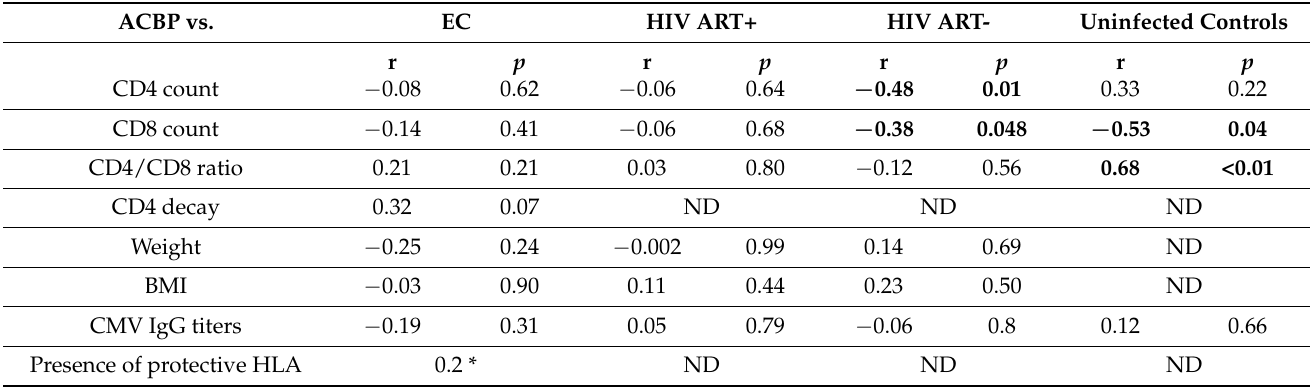
Table 1. Correlations between ACBP levels and HIV-disease progression